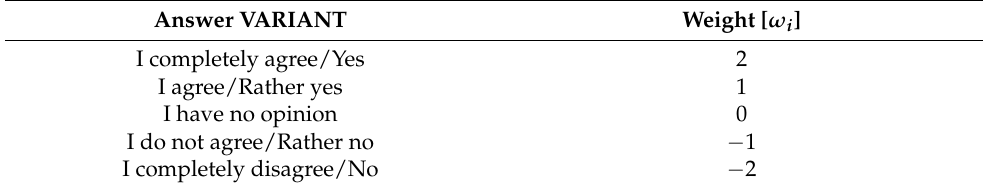
Table 1. Table of weights assigned to response options. Answer VARIANT Weight [ ω i ] I completely agree/Yes 2 I agree/Rather yes 1 I have no opinion 0 I do not agree/Rather no − 1 I completely